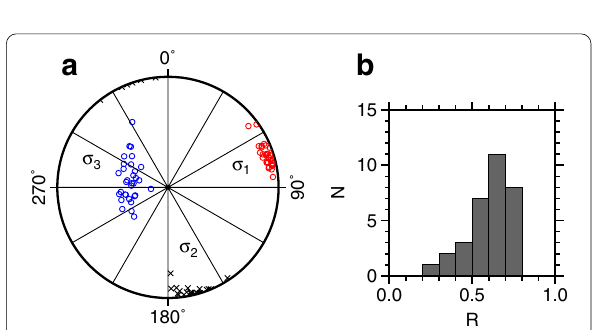
Fig. 7 Stress parameters at nodes shown in Fig. 8. a The orientation of principal stresses: red circles, crosses, and blue circles indicate σ 1 , σ 2 , and σ 3 at each node, respectively. b Histogram of the stress ratio R ( σ 1 — σ 2 )/( σ 1 — σ 3 ) =